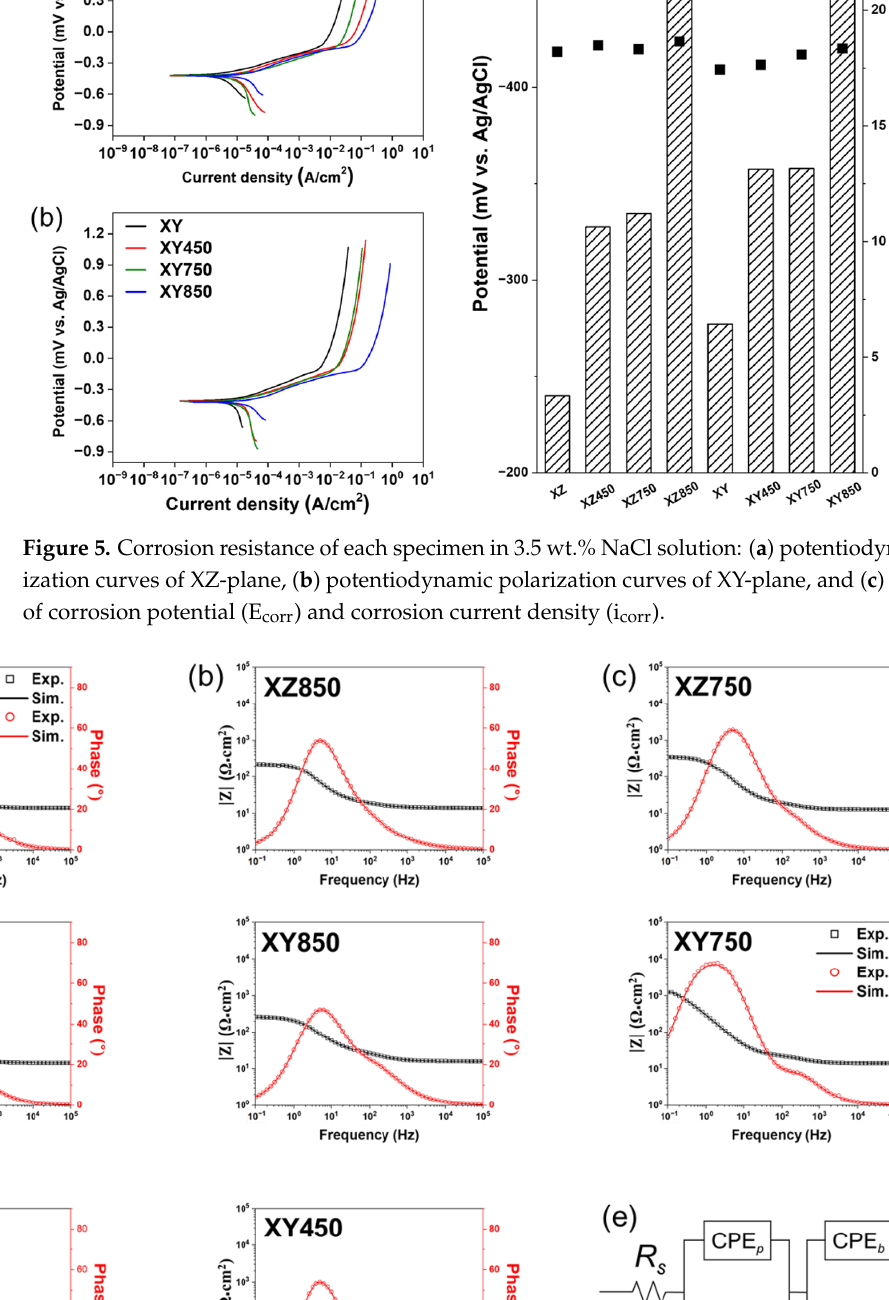
Figure 6. Bode spectra for each specimen in 3.5 wt.% NaCl solution: ( a ) as-built, ( b ) 850 ◦ C heat treated, ( c ) 750 ◦ C heat treated, and ( d ) 450 ◦ C heat treated. ( e ) Equivalent circuit for data